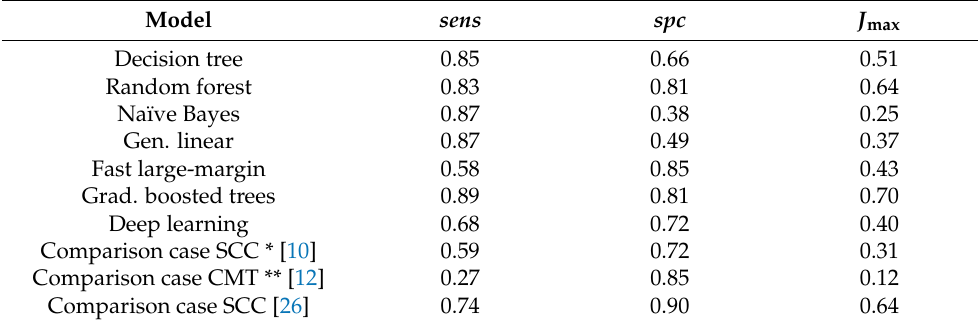
Table 1. Optimal sens, spc , and J max observed for several machine learning models and comparison literature. Here, J max is maximal Youden index. Model sens spc J max Decision tree 0.85 0.66 0.51 Random forest 0.83 0.81 0.64 Naïve Bayes 0.87